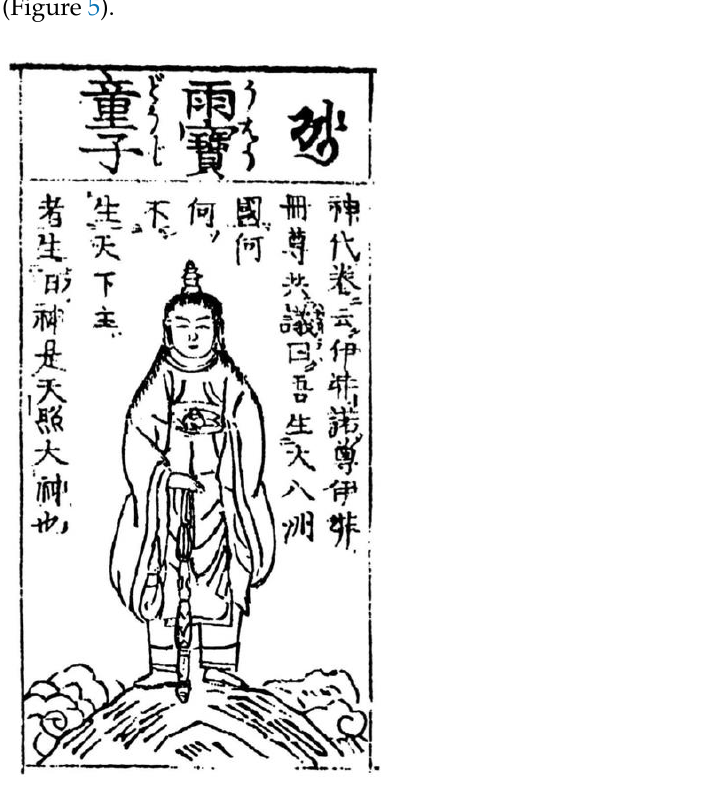
Figure 5. Woodblock print of Uhō Dōji from the Sanjūbanjin (Thirty Deities) series. Edo period. (Image courtesy of Brian Bocking (2000)).